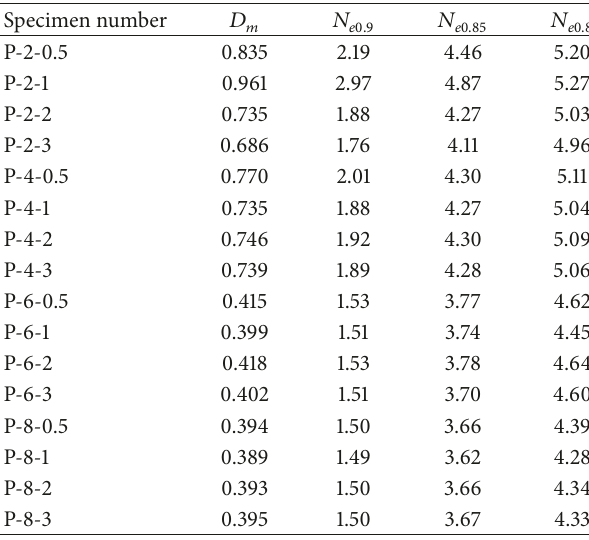
Table 5: Fatigue life.